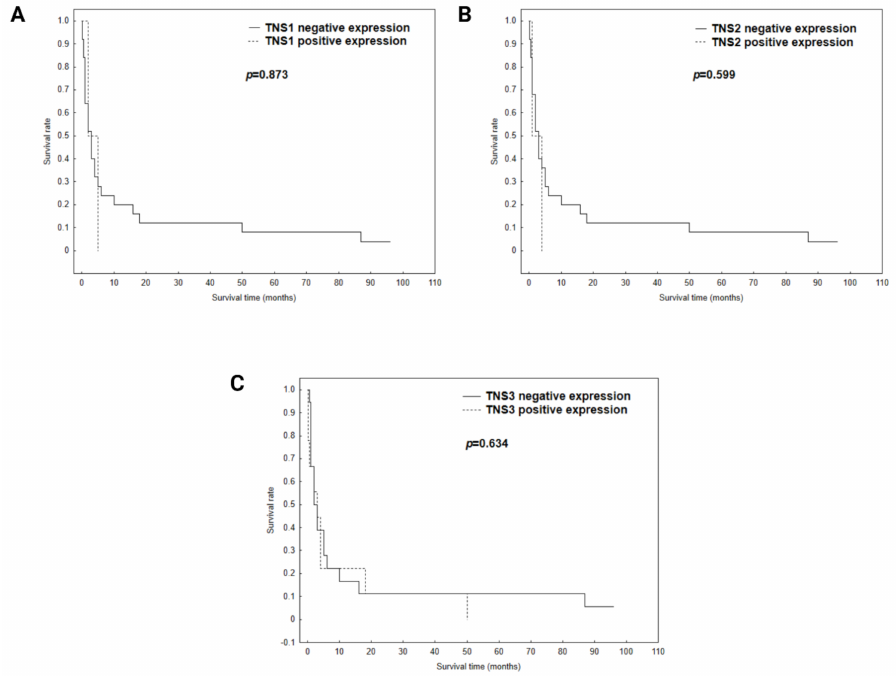
Figure 3. Total survival analysis performed using a Kaplan-Meier test of tensins in gastric cancer ( A ) TNS1; ( B ) TNS2; ( C )